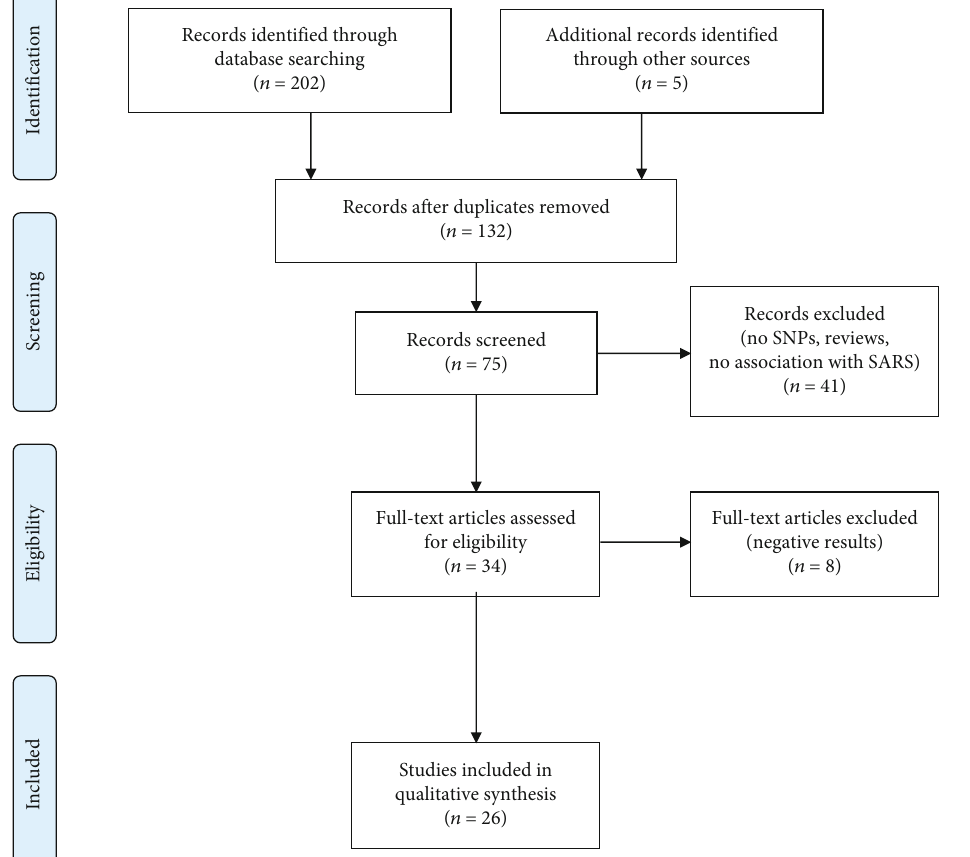
Figure 1: PRISMA fl ow diagram summarizing the selection of papers included in this systematic